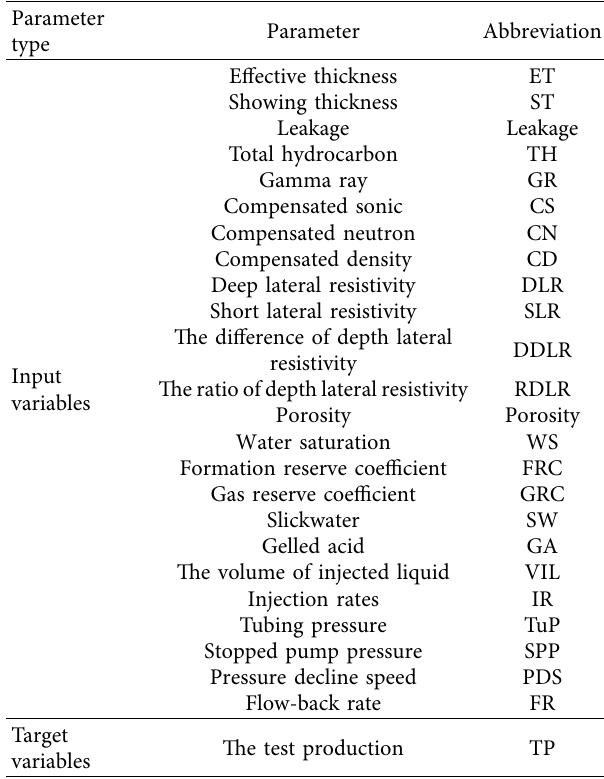
Table 1: Parameters and abbreviations for the input and target